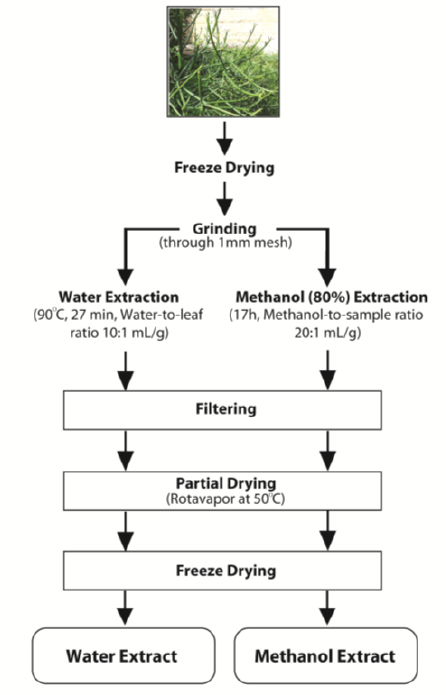
Figure 1. Schematic diagram for the extraction process for water and methanol